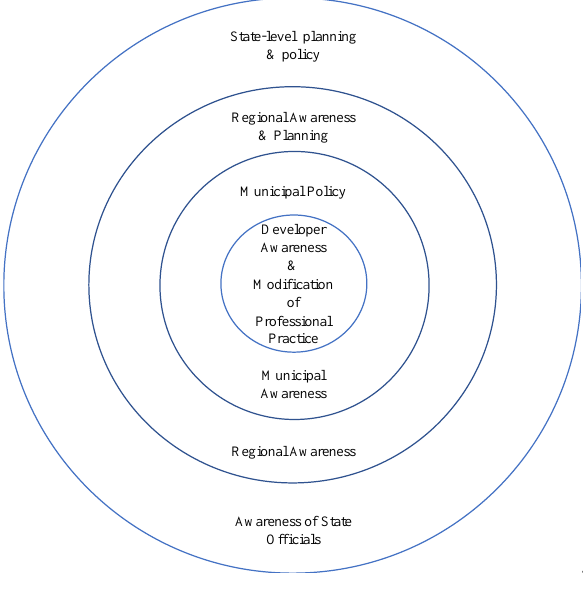
Figure 3. Levels of CAFEH impact.